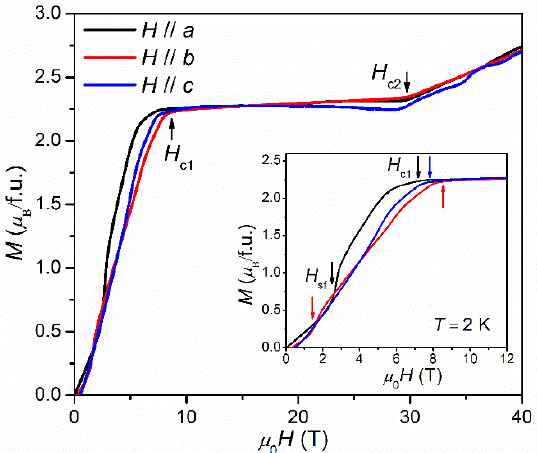
Figure A2. High-field M ( H ) curves at 2 K along the three crystallographic axes. The inset shows M ( H ) curves in the field of 0 – 12 T.